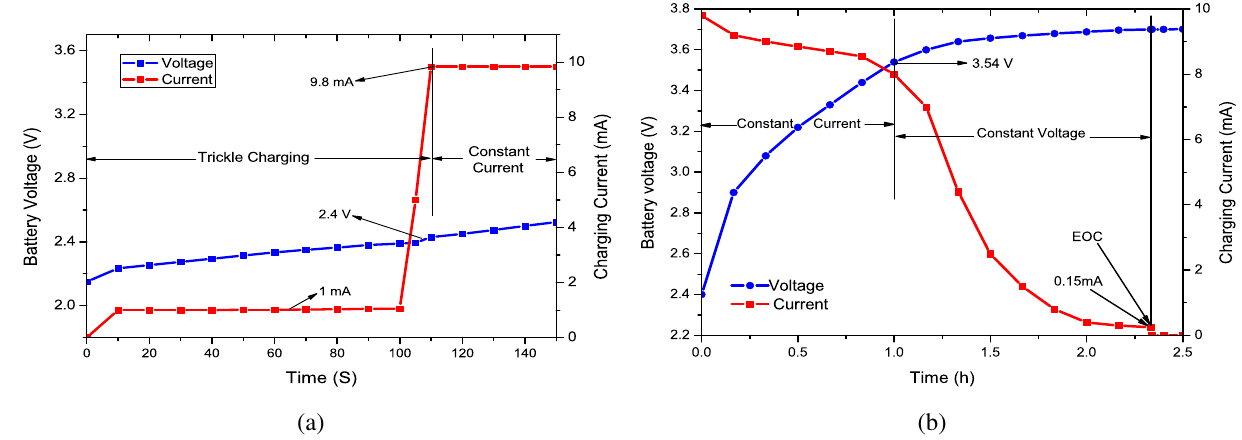
Figure 15. Measured charging current and voltage when charging a 20-mAh, 3.7-V battery. ( a ) Trickle charging regime; ( b ) constant current (CC), constant voltage (CV) and